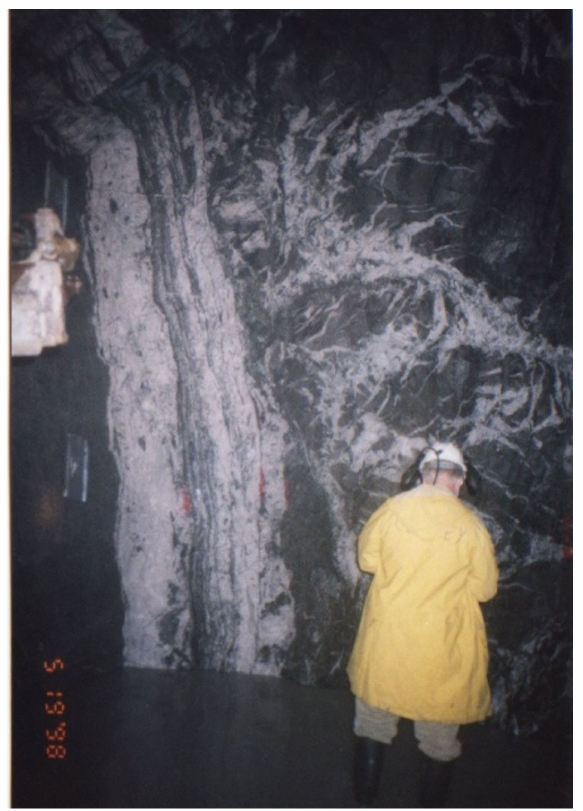
Figure 5. Hangingwall vein in the NOT at the south end of the 992 m level in Block 2E/1, where three distinct geological domains are observed. The high-grade strongly LV in the centre (0.7 m at 157 g/t Au) is associated with a massive weakly LV (0.5 m at 2 g/t Au). The spur vein zone (2.8 m at 0.5 g/t Au) on its hangingwall. The grade of the LV is 92 g/t Au over 1.2 m. The face grade is 28 g/t Au over 4 m. Brian W. Cuffley for scale.